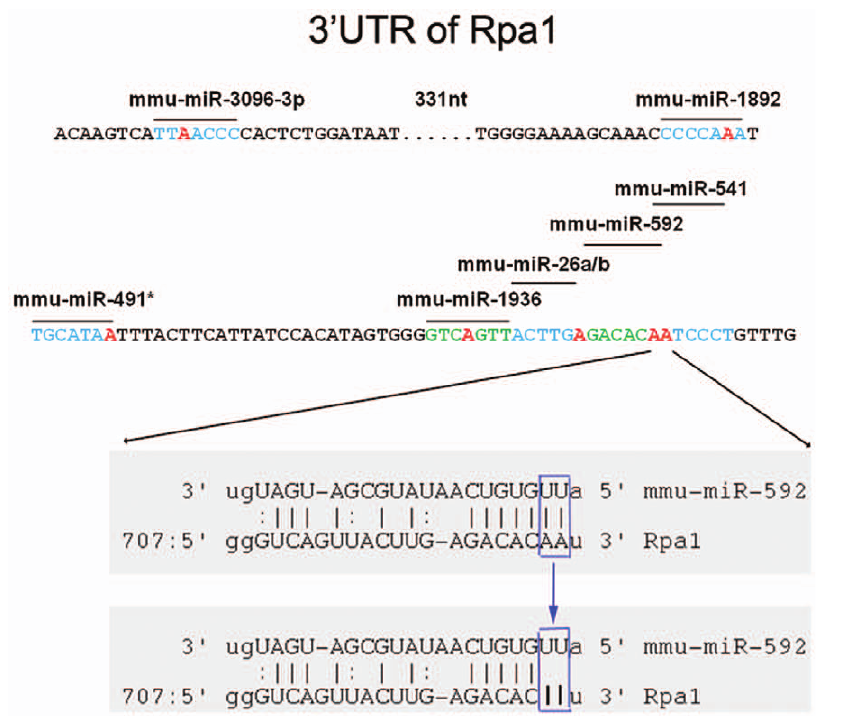
Figure 3. Example of RNA editing at microRNA target sites. One hundred nucleotides of the 3 9 UTR of Rpa1 is shown. Multiple microRNA target sites form a dense cluster in this region and contain many A-to-I editing sites. Red bases represent RNA editing sites, and blue and green bases represent different microRNA seed locations.